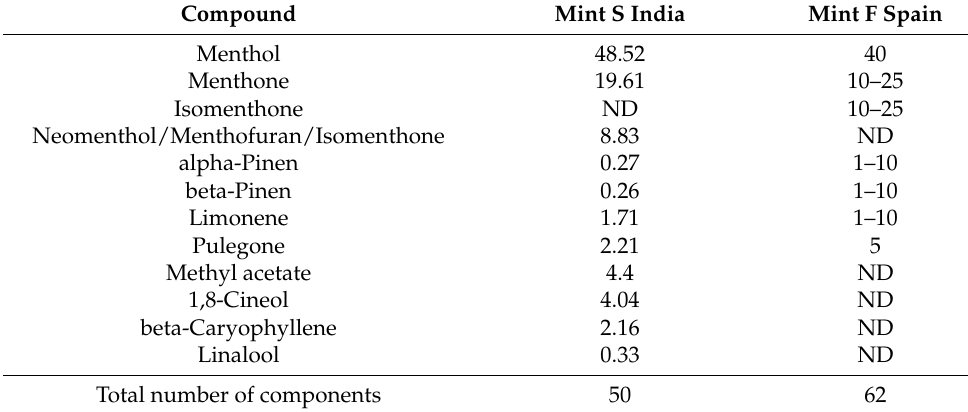
Table 2. Chemical composition of Metha piperita EOs according to